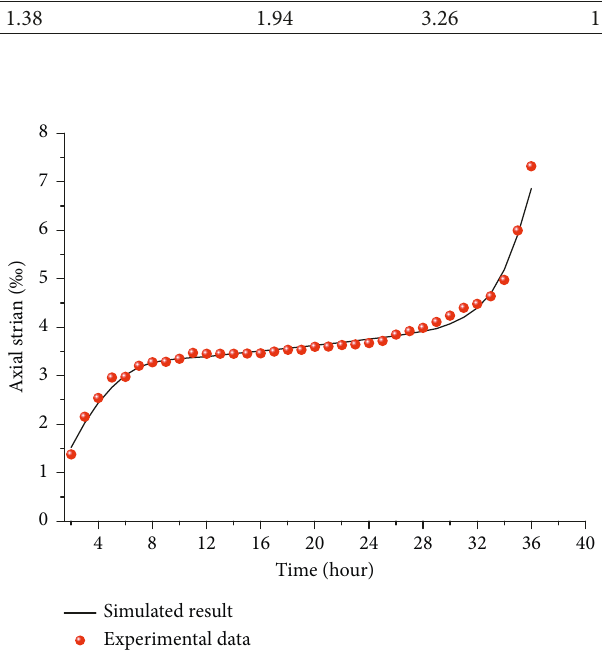
Figure 8: Comparison between experimental data and simulated results.